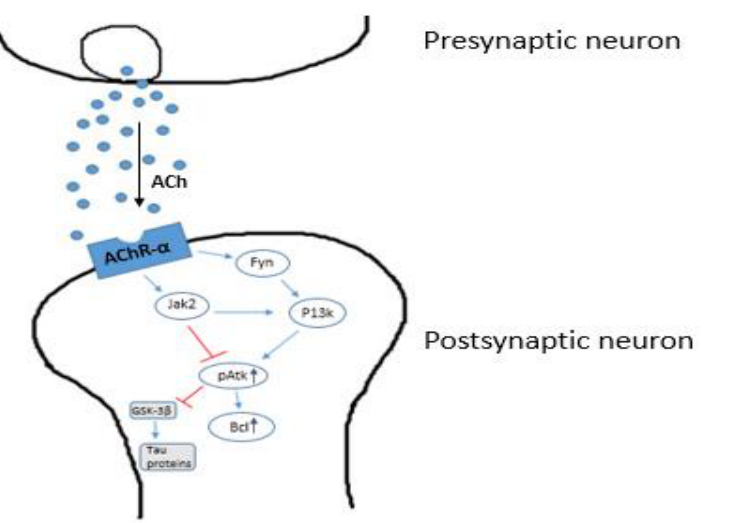
Figure 3. A diagrammatic representation of the neuroprotective activity of Acetylcholine esterase (AChE) inhibitors (such as Donepezil and Galantamine).